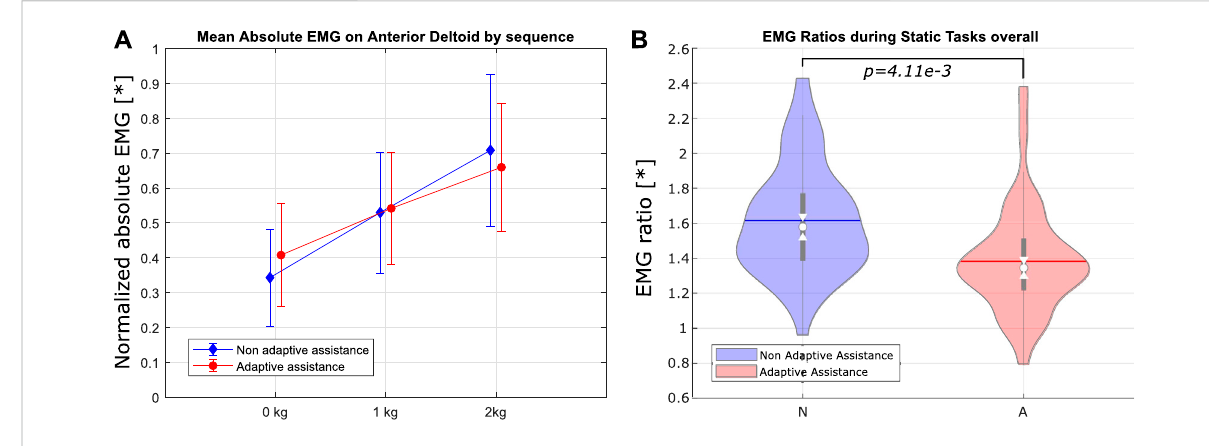
FIGURE 9 sEMGforsingle-weightsequencessortedbytheassistancemodefortheanteriordeltoid. (A) BargraphofsEMGmeasurementsbyliftedweight. (B) Violin plots of the sEMG ratios (sEMG when lifting 2 kg over sEMG when lifting no weight) by the assistance